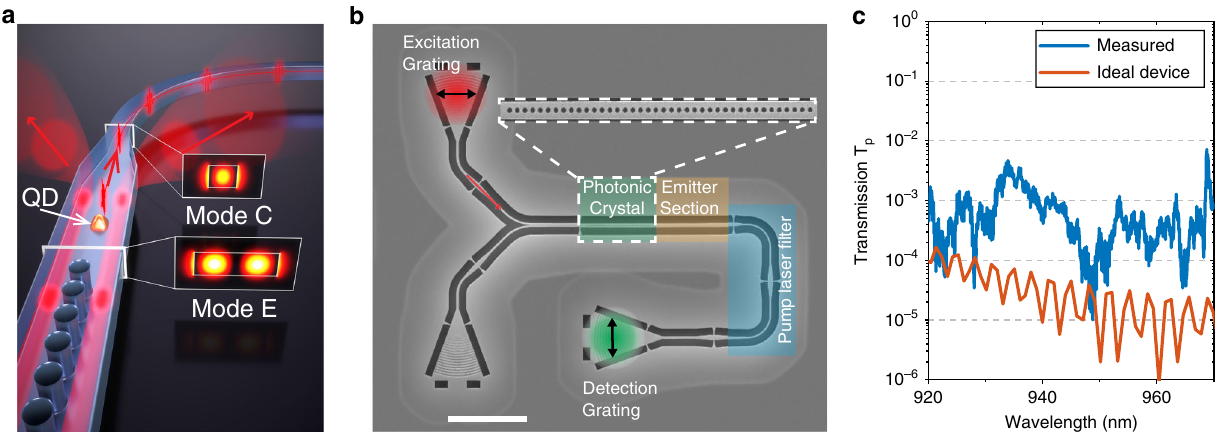
Fig. 1 Waveguide-based excitation scheme. a Illustration of the mode fi ltering operation. The resonant pump laser in the fi rst-order waveguide mode excites the emitter and is subsequently squeezed out of the waveguide in the taper section. The QD emission into the fundamental mode of the waveguide is collected ef fi ciently and guided. The photonic crystal acts a mirror for the fundamental mode, thereby enabling the directional out-coupling of the QD signal. b Scanning electron microscope image of the fabricated device (length of scale bar is 10 μ m). The excitation and collection spots are highlighted with red and green spots. The Y-splitter is used to excite the fundamental and fi rst-order modes of the waveguide. The photonic crystal (zoomed in the inset to highlight the lattice of air holes) selectively transmits only the fi rst-order mode into the emitter section. The pump laser fi lter section is composed of a waveguide taper and two 90 ∘ bends to suppress the pump laser. The bottom-left grating is used to align the in-coupling of the laser beam by monitoring the re fl ected signal from the photonic crystal. c The measured and calculated transmission T p spectrum of the device for a laser coupled in at the excitation grating and collected at the detection grating.